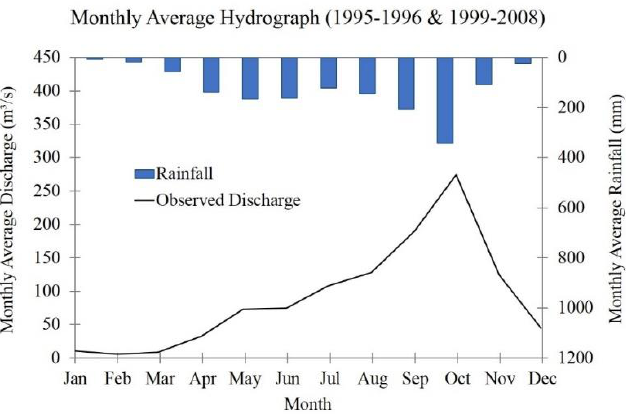
Figure 12. Monthly average hydrograph at Bak Trakuon Station during the calibration period from 1995 to 2008 (excluding 1997 and 1998 when rainfall data were missing).